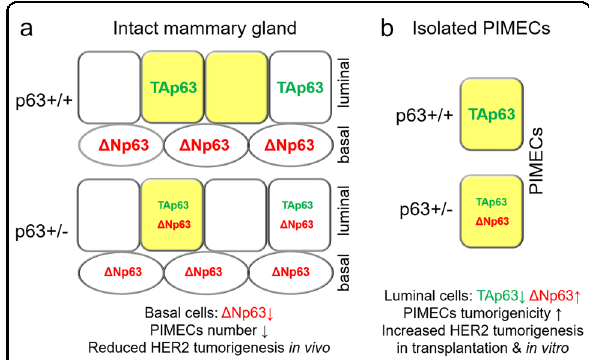
Fig. 6 A model integrating the roles of p63 isoforms in PIMECs and pregnancy-associated HER2-positive breast cancer. a In the post-parous whole mammary gland, Δ Np63 (expressed in the basal cells) non-cell-autonomously maintains the post-pregnancy PIMEC pool, whereas TAp63 (expressed in select luminal cells) has minimal or no effect. This results in a decreased PIMEC number and suppressed HER2 tumorigenesis in p63 + / − ;ErbB2 females 15 . b In isolated wild- type PIMECs, the tumor suppressor TAp63 is the main isoform and suppresses their intrinsic tumorigenic properties, as well as keeps at bay oncogenic Δ Np63. In p63 + / − ;ErbB2 PIMECs, TAp63 is reduced, resulting in increased tumorigenic properties, due to Δ Np63 upregulation and activation of oncogenic and self-renewal pathways. Yellow,